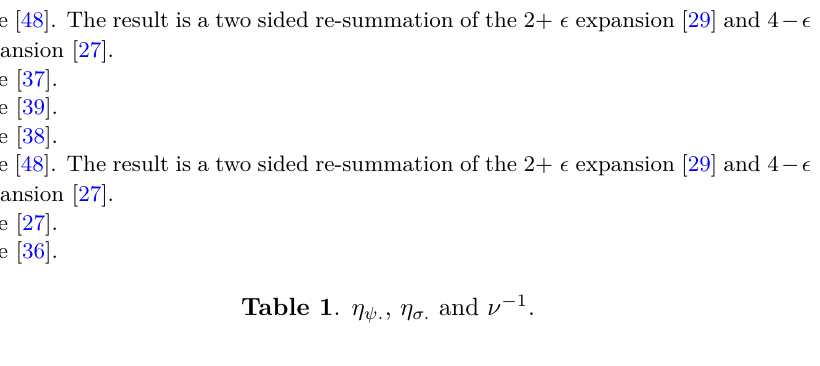
Table 1 . η ψ. , η σ. and ν − 1